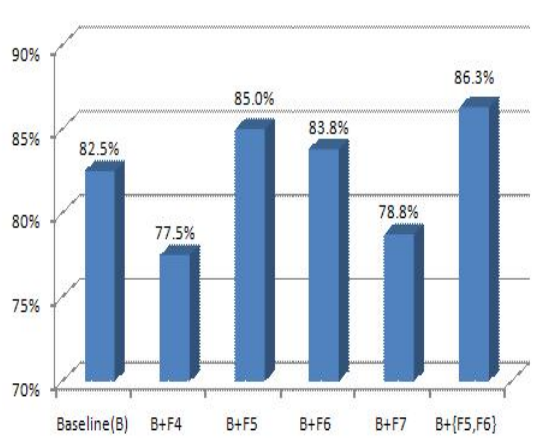
Fig. 6. Classification accuracy of each feature set.(Source: findings from the experiments of this